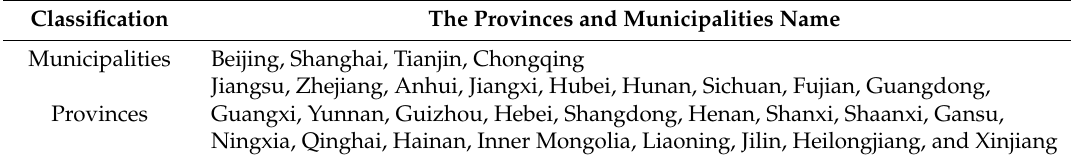
Table 2. The provinces and municipalities name of China in this